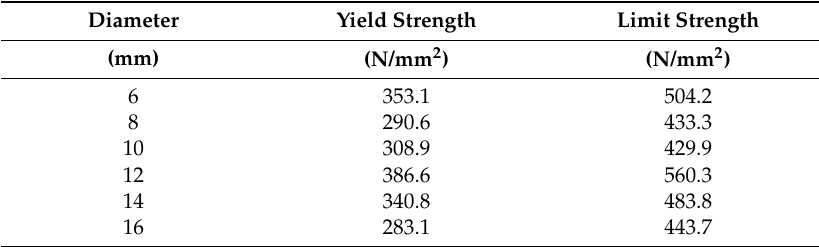
Table 3. Material properties of the steel reinforcement.